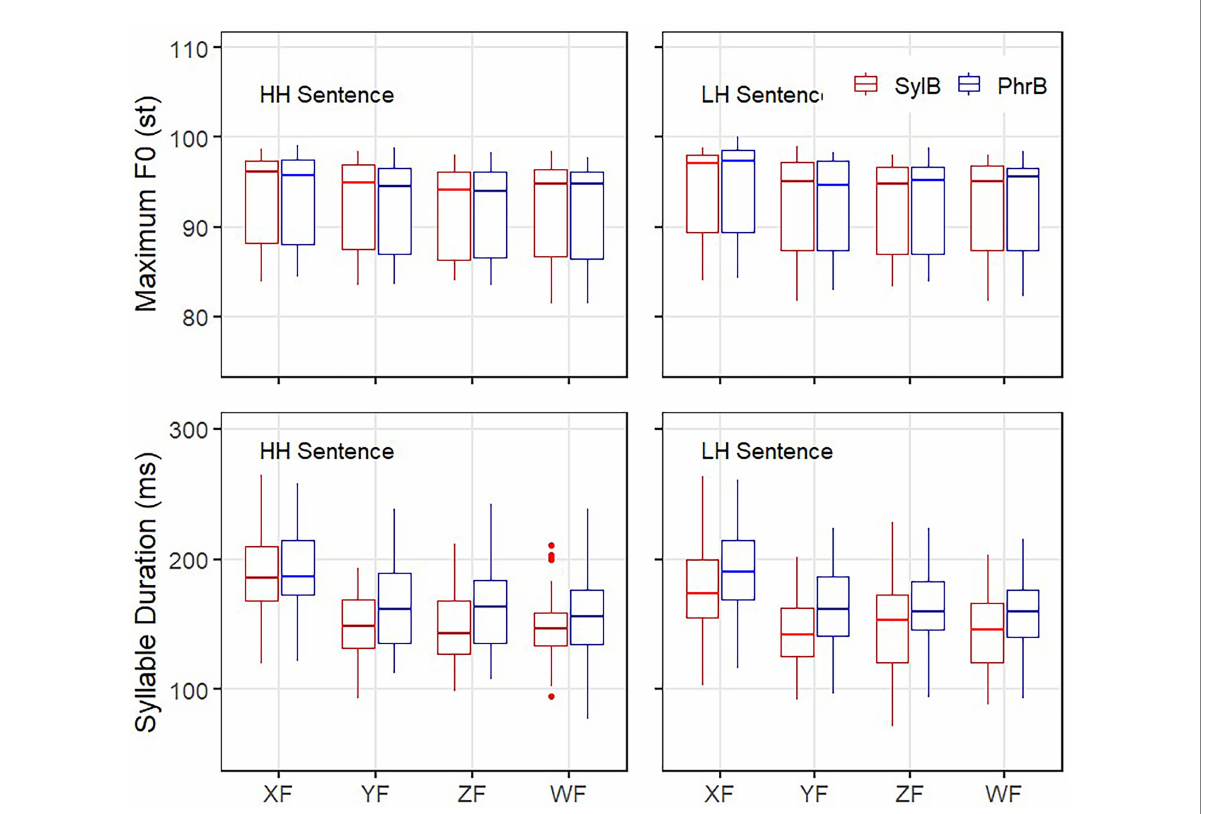
FIGURE 4 Maximum F0 and duration of syllable X in the H X H Y (left) and L X H Y (right) sentences in the two boundary conditions (SylB and PhrB) and the four focus conditions.